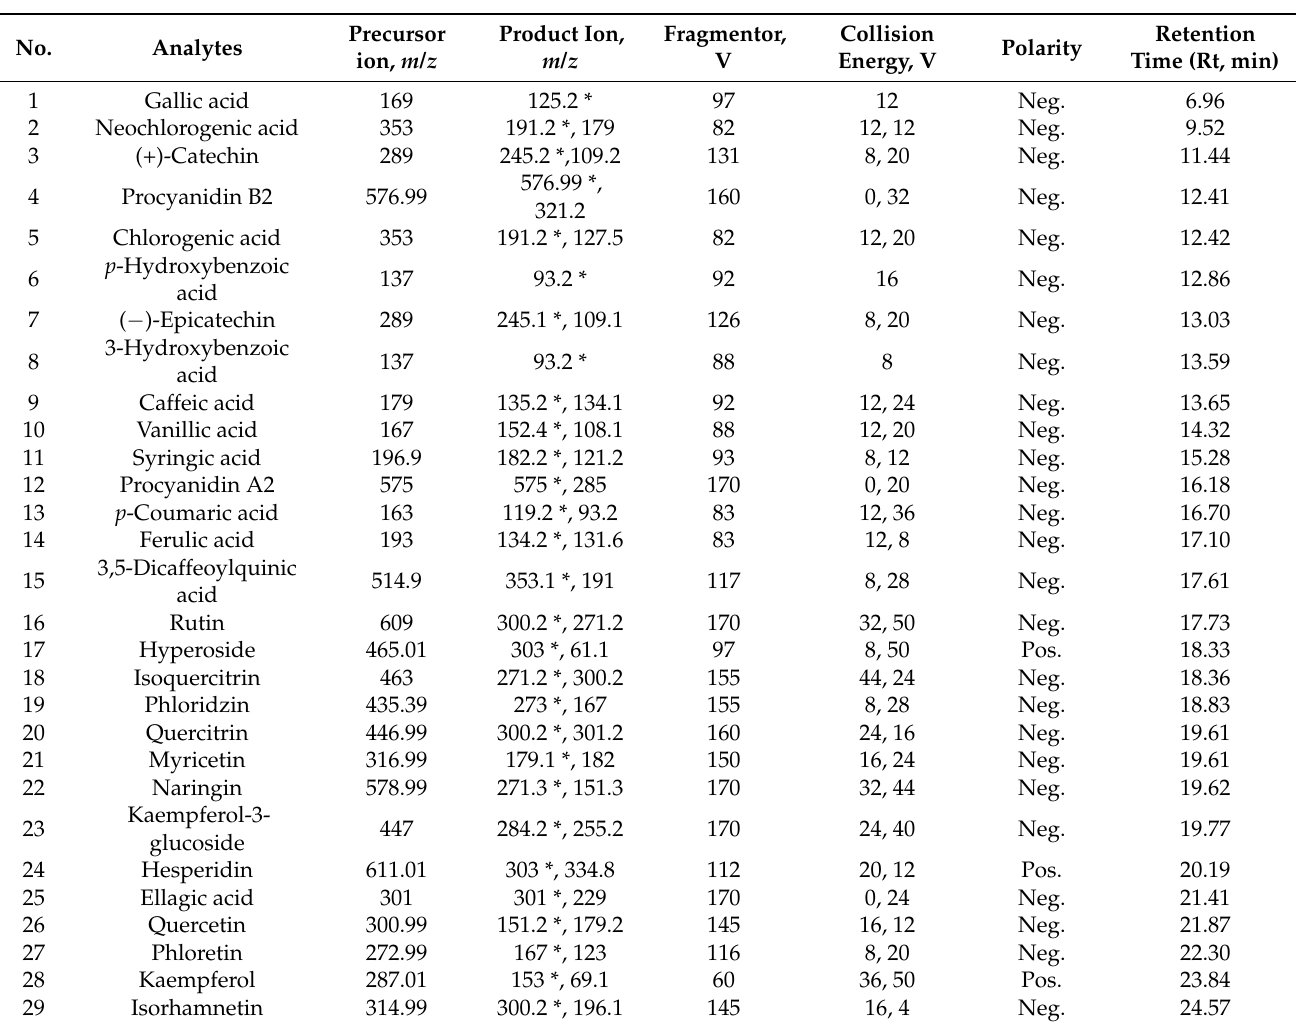
were in the range of 1.20–10.00 µ g/L, showing high sensitivity. The intraday and interday precisions were determined via the injection of the standard mixture solution five times a day, and once a day on three consecutive days, respectively. The developed method showed a great precision as the relative standard deviations (RSDs%) were in the range of 0.34–4.73% in case of interday variations, and ranged from 0.12 to 2.62% for intraday variations. Evaluation of the method specificity was done by setting multiple pairs of precursor/product ions and measuring the stability of retention time, and a high specificity was obtained using HPLC-MS/MS working in dynamic-MRM mode. Retention time stability for each molecule was studied three times over a period of 3 days and expressed by RSDs%, which were in all cases ≤ 1.0%. Similar results were reported in our previous work [19]. The mass spectrometer parameters and the selected ion transitions for the analyzed compounds are reported in Table 1, and the HPLC-MS/MS chromatogram of a standard mixture of the 29 analytes plotted as an overlapped MRM transition of each monitored compound is shown in Figure 1. Acquisition parameters of HPLC-MS/MS (dynamic-MRM mode) used for the analysis of the 29 phenolic